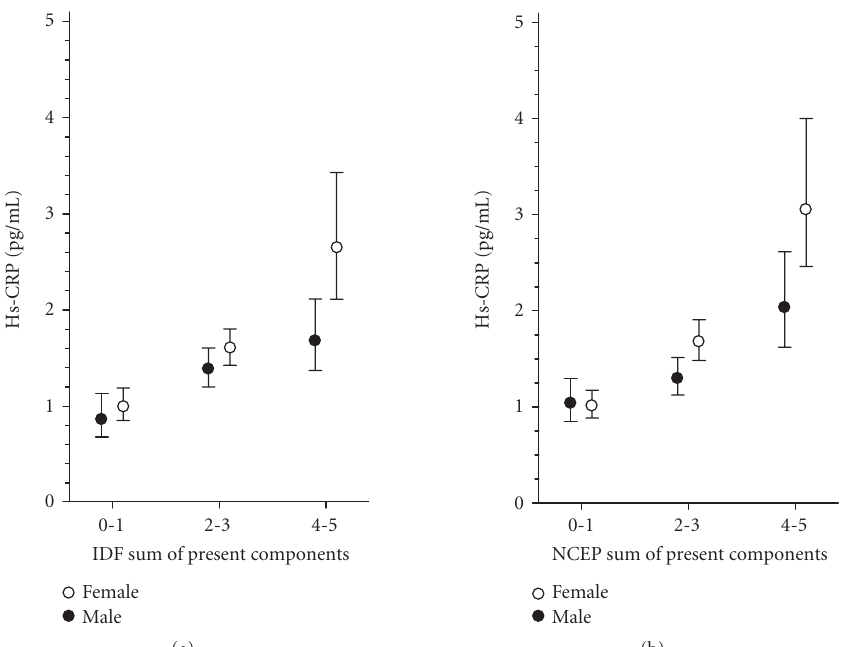
Figure 2: Relationship between high-sensitivity C-reactive protein (hs-CRP) and the number of the components of the metabolic syn- drome according to the IDF and NCEP criteria (95% confidence interval obtained by bias-corrected and accelerated bootstrapping (5000 replications)).